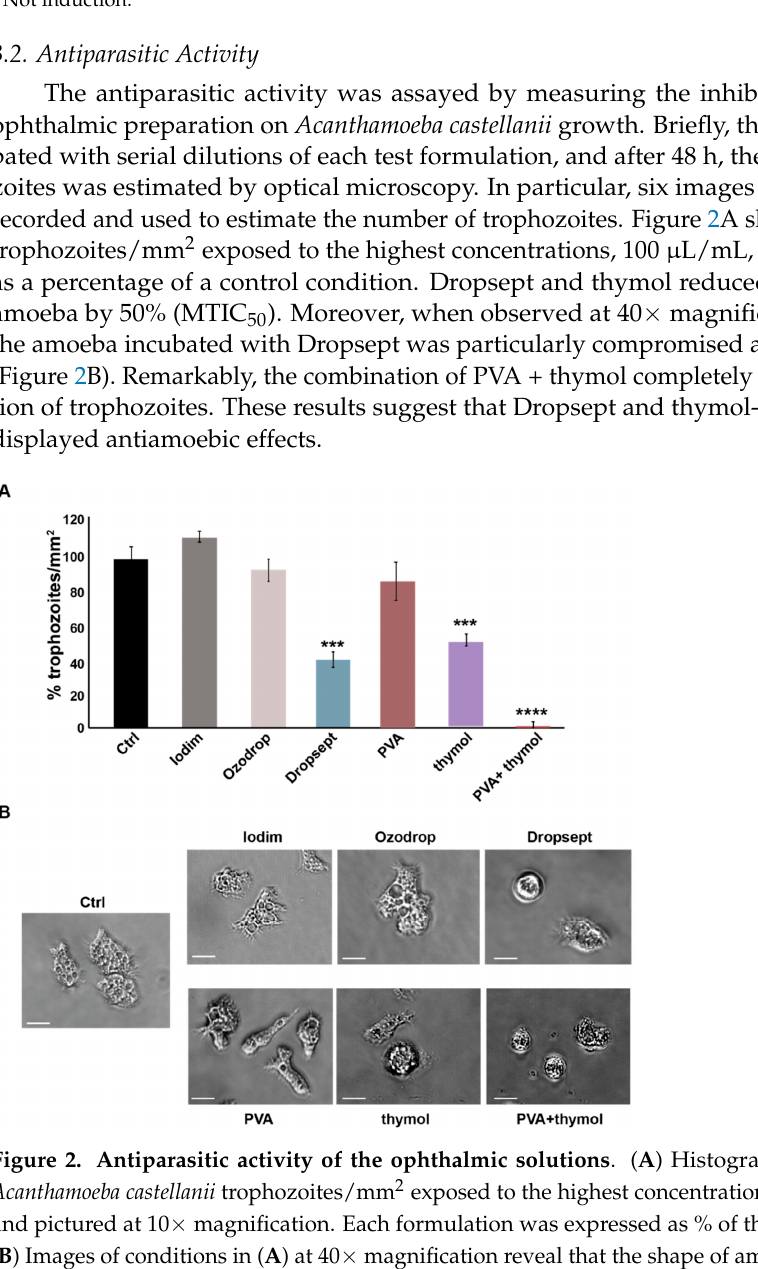
Table 9. Challenge test on P. aeruginosa .